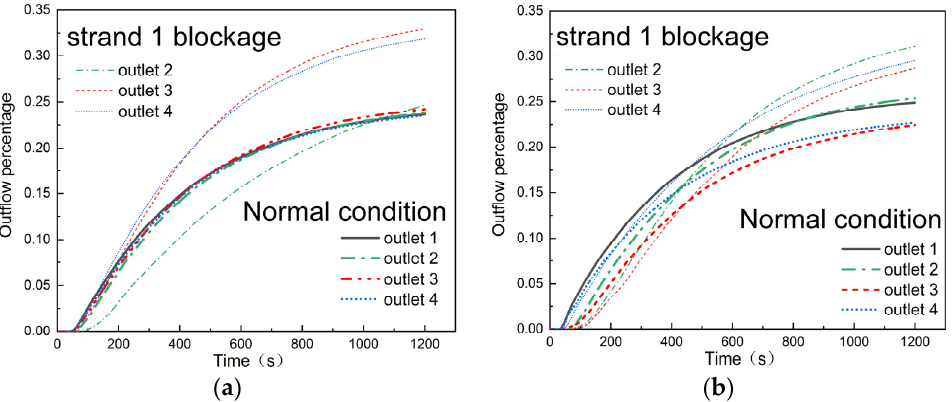
Figure 11. Outflow percentage curve of four-strand tundish under single-strand blockage and normal conditions: ( a ) double-weir tundish, ( b ) u-shaped weir tundish.